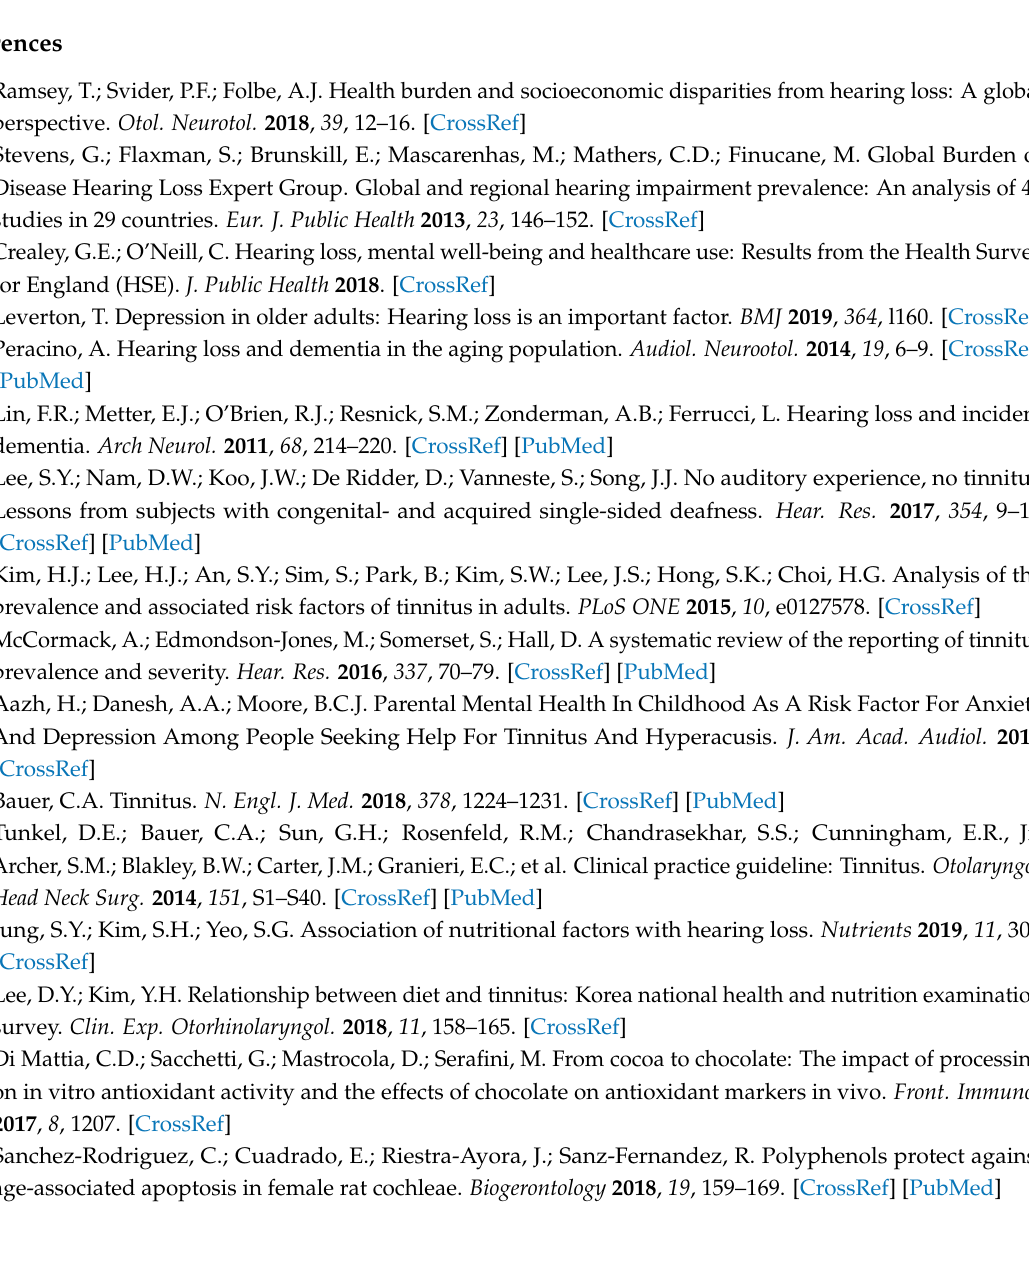
Table S1: Assessment of chocolate consumption Food-Frequency Questionnaire (FFQ); Table S2: Subgroup analysis regarding effect of chocolate on hearing loss and tinnitus according to